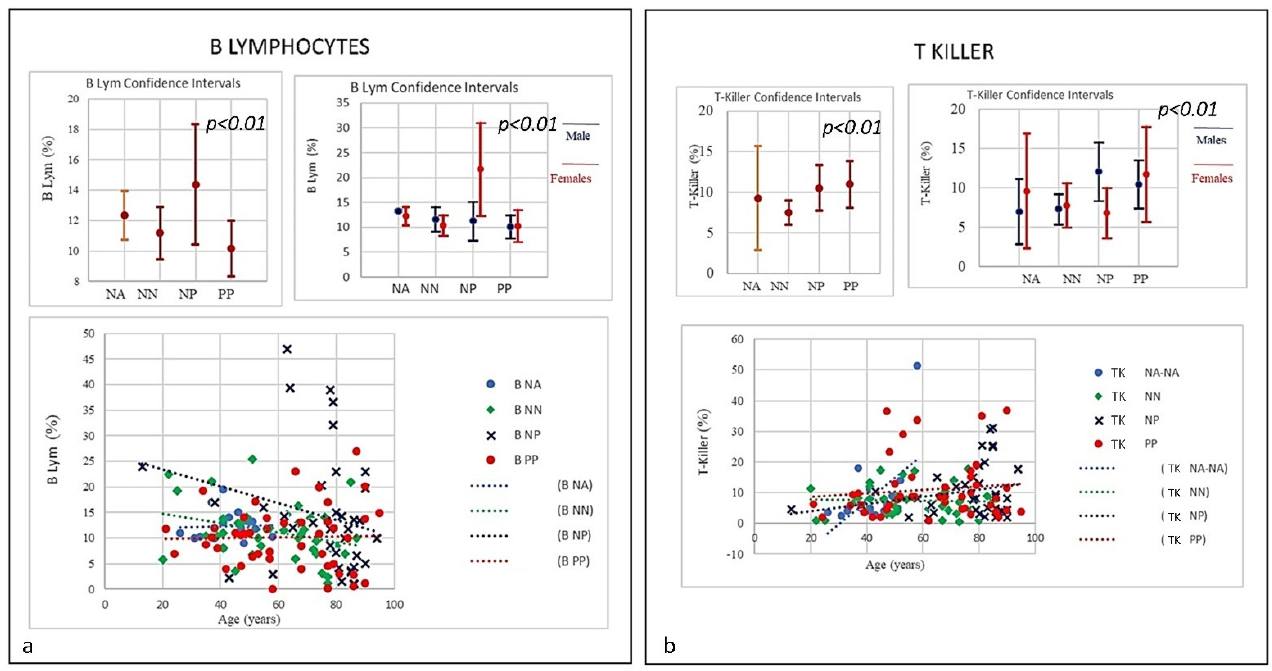
Figure 5. ( a ) Frequencies of B Lymphocytes in COVID-19 patients and controls (NP, NN, and NA). Data revealed a linear decrease in levels of B-lymphocytes. PP individuals at time of the admission showed a low level of B lymphocytes, though both NP and NN individuals started with a higher level of B cells showing a decrease correlated with the age. ( b ) Frequencies of T- and N killer Lymphocytes in COVID-19 patients and controls (NP, NN and NA) there was an increase in the three groups PP and NP (high) and NN (low) suggestive of active capability of immunity to respond as killer T cell recognizes and kills virus-infected cells because of the viral antigen on its surface.